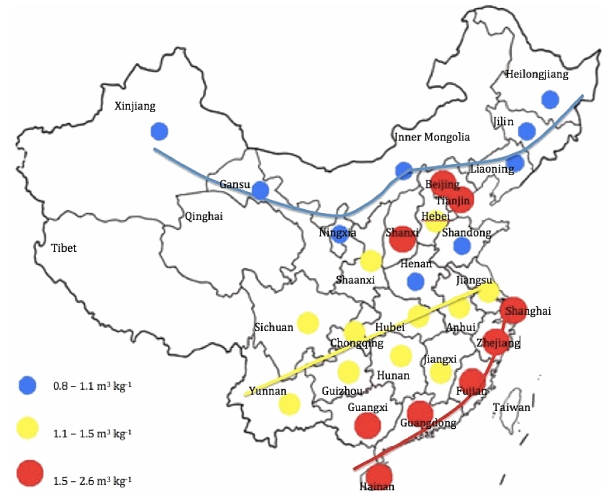
Figure 4. Direct grey water of rice (m 3 kg − 1 ) . Figure 5. Total VWC of rice (m 3 kg